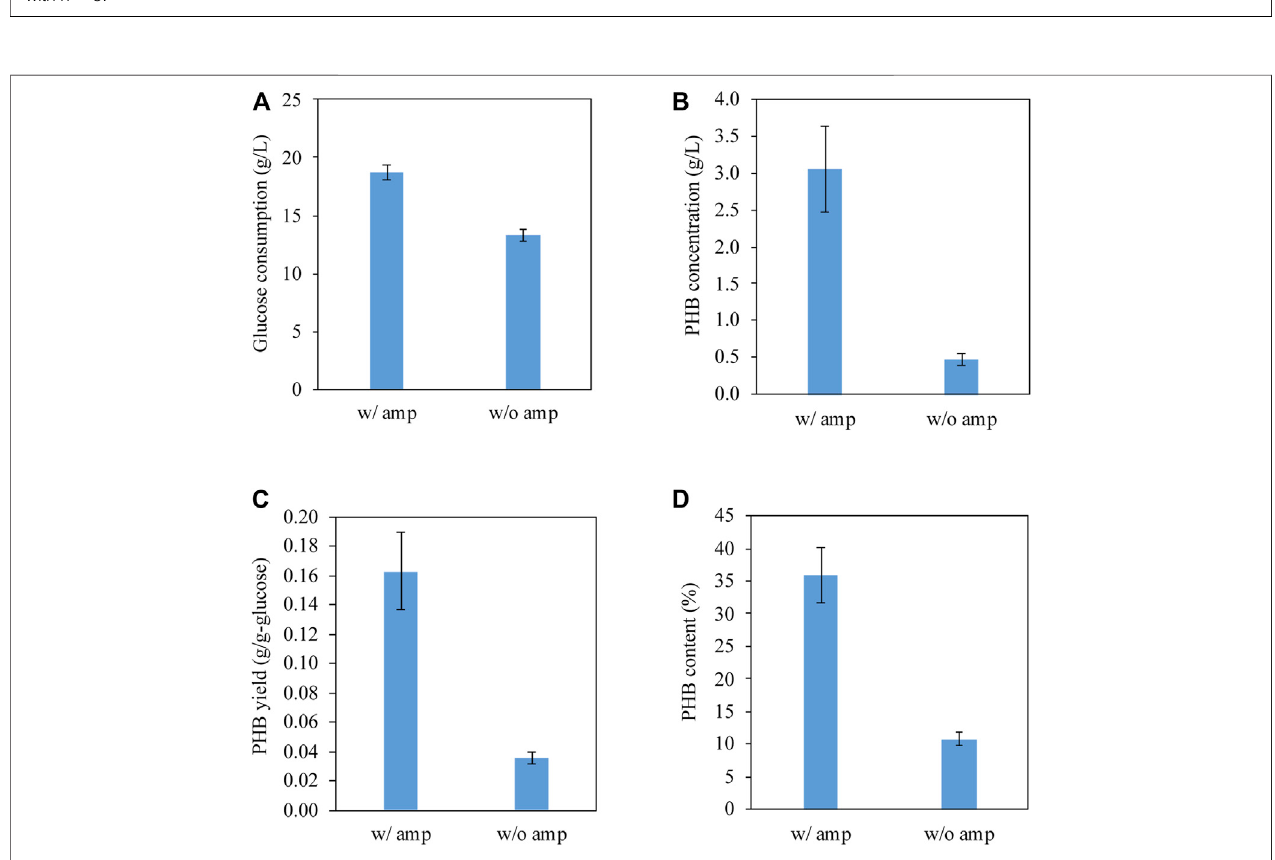
FIGURE2| TheplasmidstabilitytestofpUC19,pVEC01,pVEC02,andpVEC03in E.coli strains (A) DH5 α and (B) BL21(DE3).Errorsrepresentstandarddeviation with n = 3.